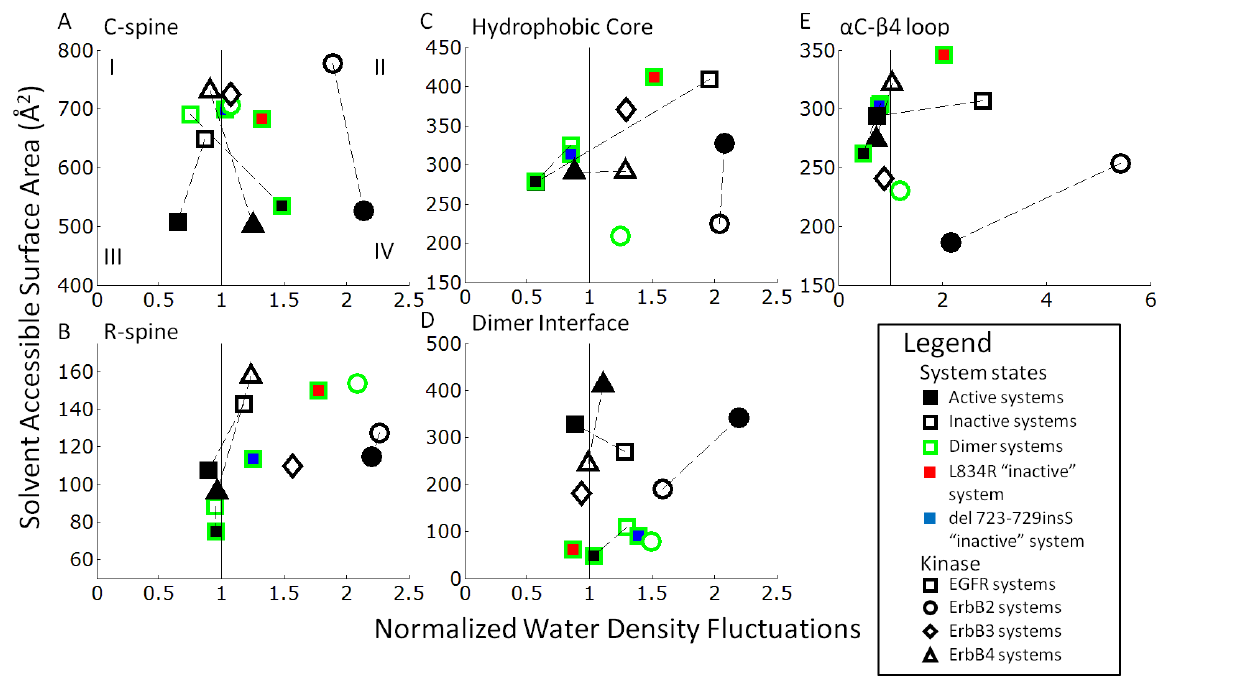
Figure 4. Hydrophobic plots of the solvent accessible surface area (SASA) versus normalized water density fluctuations in the key hydrophobic regions of the ErbB kinases: ( A ) C-spine; ( B ) R-spine; ( C ) Hydrophobic Core; ( D ) Dimer Interface; and ( E ) αC-β4 loop. The edge colors represent monomer (black) and dimer (green) systems. The shape internal color represents active (black) and inactive (white) for the wildtype systems. The mutant systems of EGFR L834R in the inactive conformation are red while the EGFR del 728-729insS mutant system is blue. The shape itself represents a different member of the ErbB family EGFR (square), ErbB2 (circle) and ErbB4 (triangle). The quadrants represent different hydrophobic interaction regions (I) hydrophilically favorable region, (II) perturbation-sensitive region and (IV) hydrophobically favorable region. It is not clear if quadrant III represents a favorable or unfavorable region as it represents a buried hydrophilic